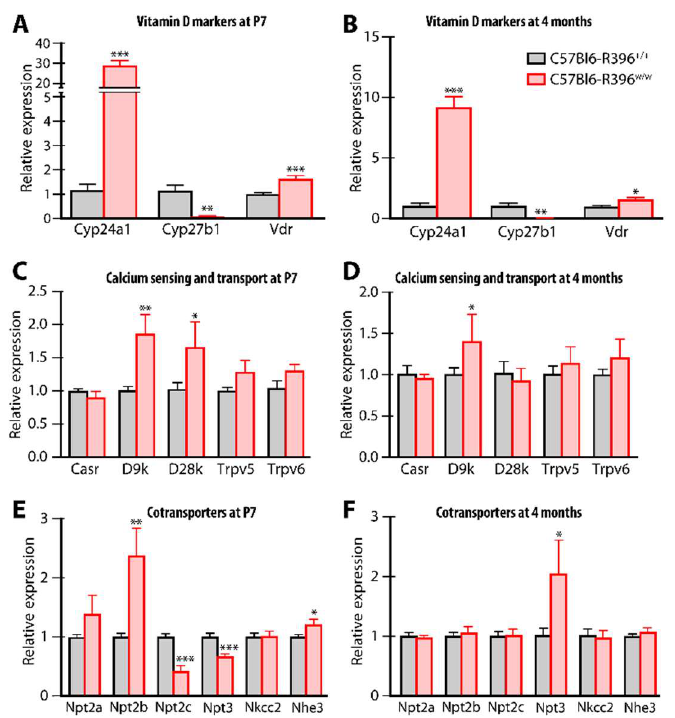
Figure 4. Gene expression monitoring in newborn and adult C57Bl6-R396 littermates.